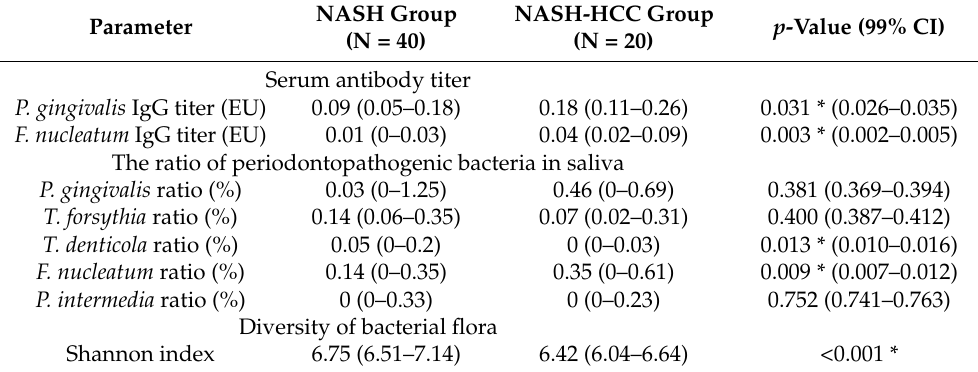
Table 3. Bacterial